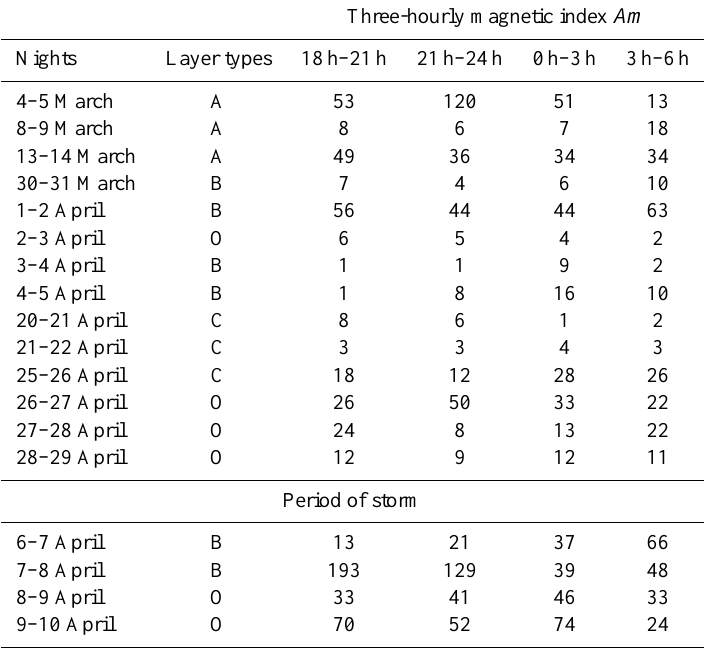
Table 3. Three-hourly magnetic index Am , for the night plotted in the different figures; the part called “Period of Storm” corresponds to nights not plotted in this